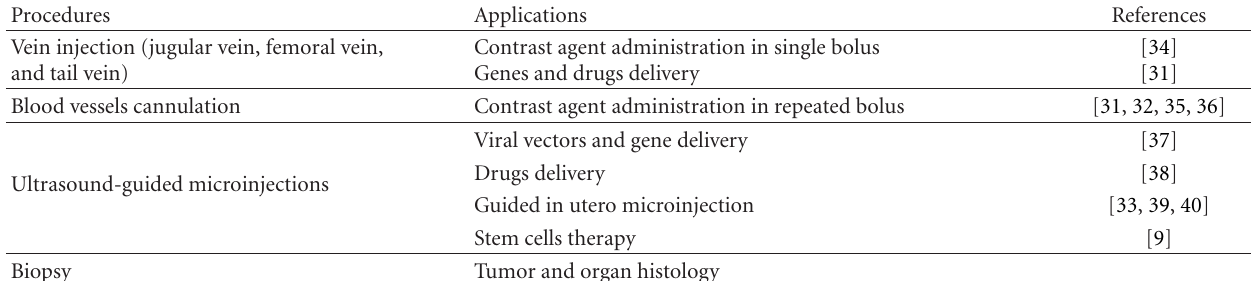
Table 1: Specific procedures related to